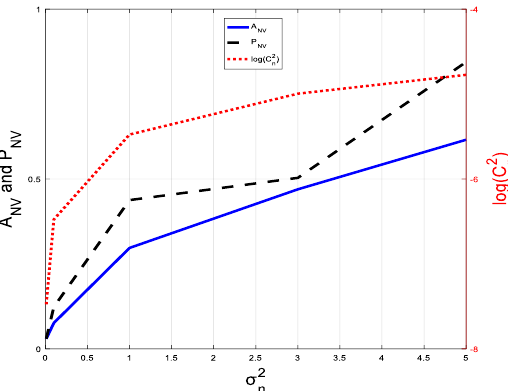
Figure 8. Changes of C 2 n , A NV and P NV with σ n 2 . (blue: A NV ; black: P NV ; red: C 2 n